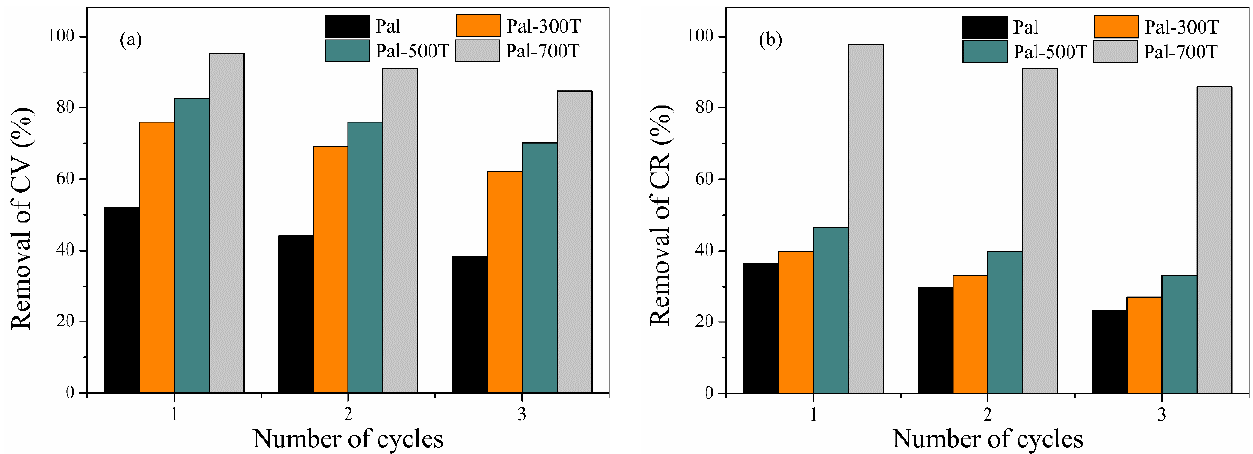
Figure 13. Reusability of palygorskite before and after heat treatment for three cycles to remove the dyes ( a ) crystal violet and ( b ) congo red.